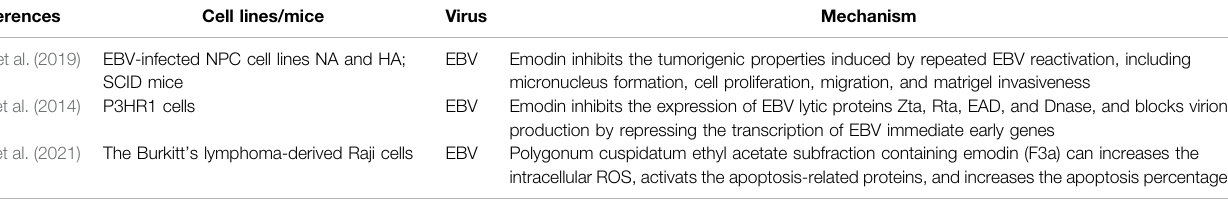
TABLE 3 | Anti-EBV activities of emodin.